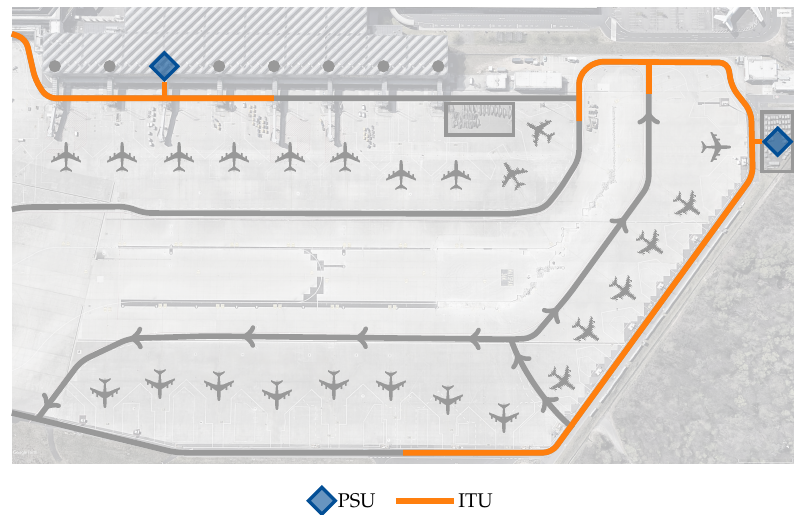
Figure 3. Exemplary dynamic inductive charging infrastructure on the apron of Cologne Bonn Airport. Source: Cologne Bonn Airport [online], 50 ◦ 52 (cid:48) 56 (cid:48)(cid:48) N 7 ◦ 07 (cid:48) 10 (cid:48)(cid:48) E, Height 574m, Google Earth © GeoBasis-DE/BKG 2009, URL: http://www.google.com/earth on 29 June